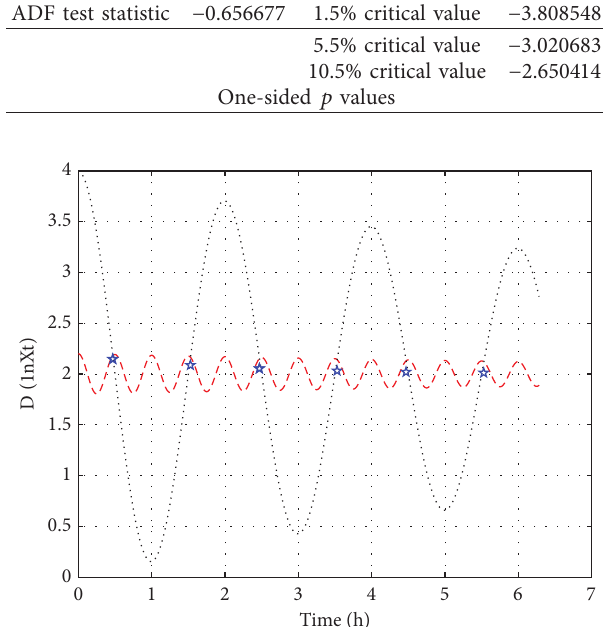
Figure 4: First-order difference sequence